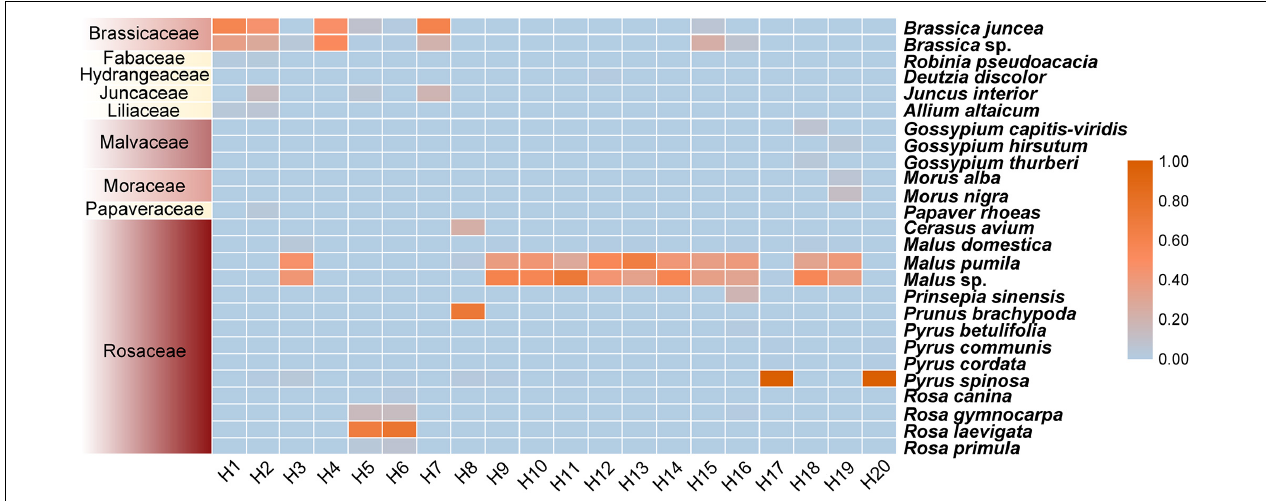
FIGURE 1 | Composition and relative abundance of pollen plants. The left and right of the Y -axis and the X -axis represent the family and species of pollen plants and sampling plot, respectively. The legend in the upper right represents the proportional abundance of pollen